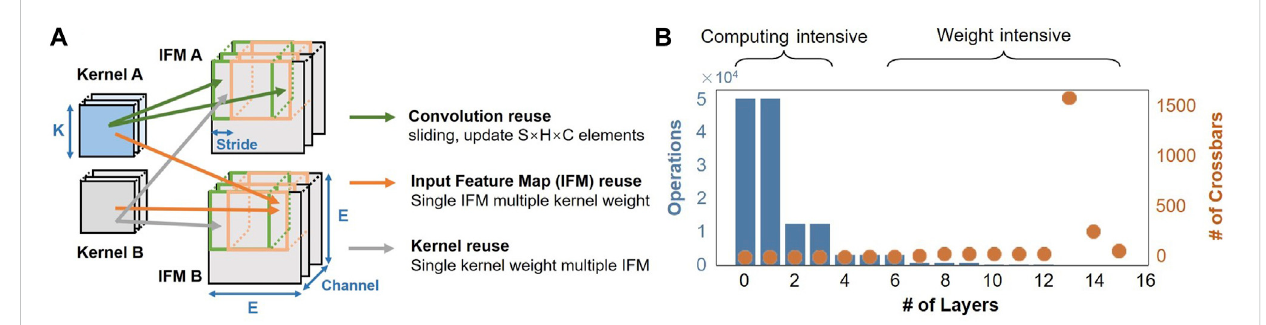
FIGURE 1 (A) Illustration of data reuse and (B) data fl ow bottleneck in CNNs.